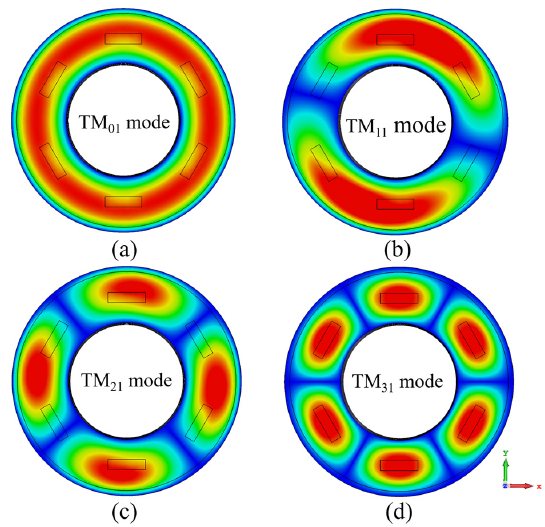
Figure 5. The electric field contour diagram of different modes in the x–y plane. ( a ) TM 01 mode, ( b ) TM 11 mode, ( c ) TM 21 mode, and ( d ) TM 31 mode. Beam-loading conductance G e represents the energy exchange between the electron beams and the external circuit. The normalized beam-loading conductance G e is [25] where M ( β e − β q ) and M ( β e + β q ) can be expressed as 𝑀(cid:3435)𝛽 (cid:3032) (cid:3399) 𝛽 (cid:3044) (cid:3439) (cid:3404) (cid:1516) 𝐸(cid:4666)𝑧(cid:4667)𝑒 (cid:3037)(cid:3435)(cid:3081) (cid:3280) (cid:3399)(cid:3081) (cid:3292) (cid:3439)(cid:3053) 𝑑𝑧 (cid:2998) (cid:2879)(cid:2998) (cid:1516) |𝐸(cid:4666)𝑧(cid:4667)|𝑑𝑧 (cid:2998) (cid:2879)(cid:2998)